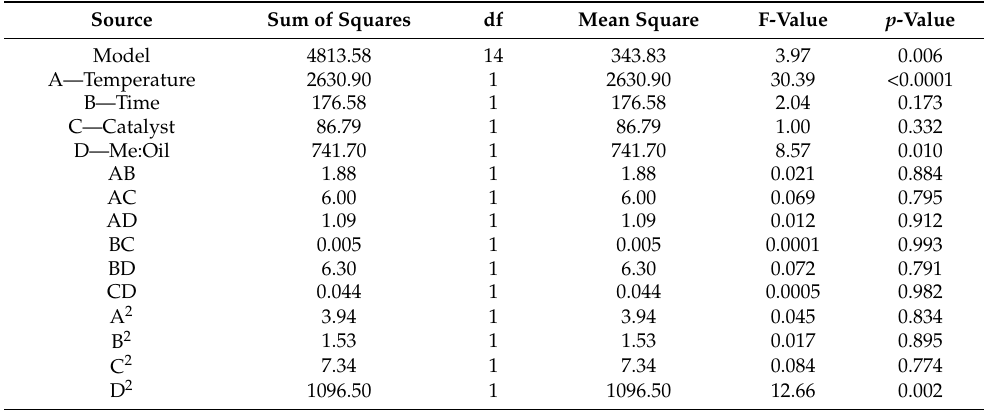
Table 5. ANOVA for the predicted model and for each experimental process parameter.